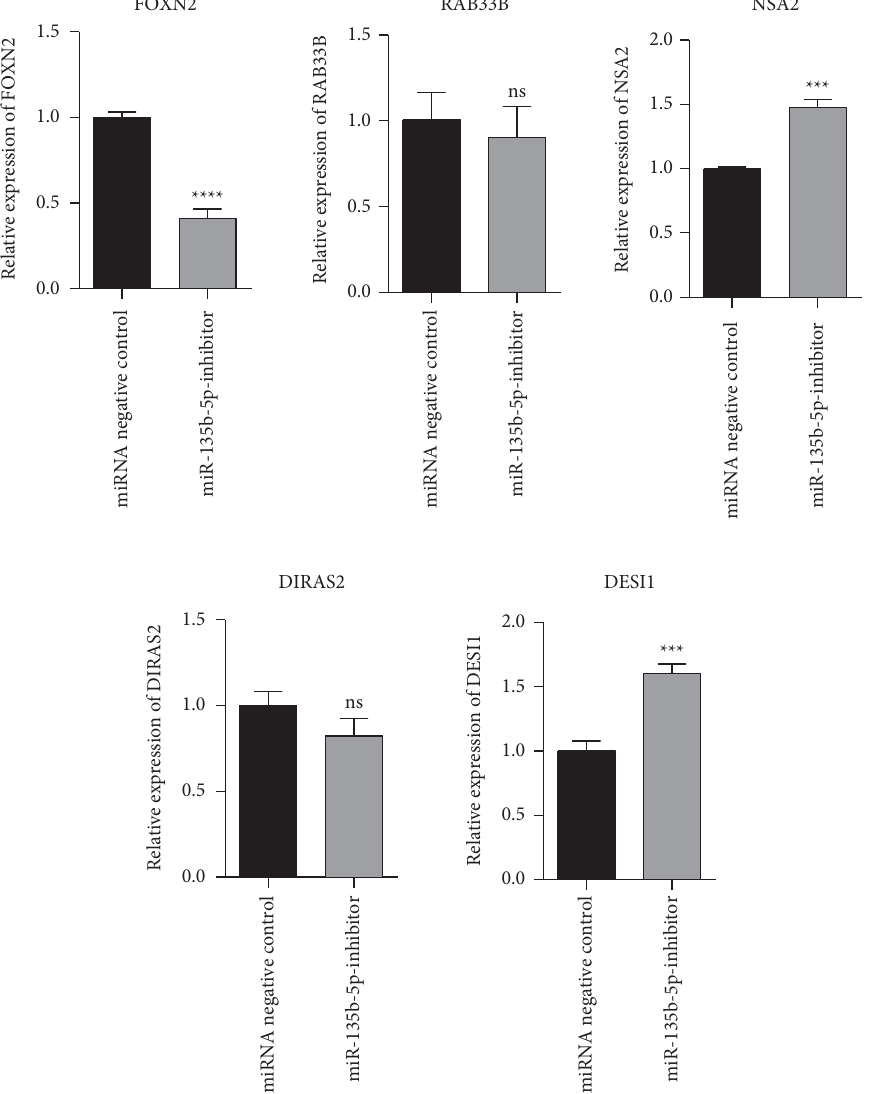
Figure 8: Validation analysis of the prognosis-related genes. ∗∗∗ P < 0 . 001, ∗∗∗∗ P < 0 . 0001, and “ns” represents no signifcant